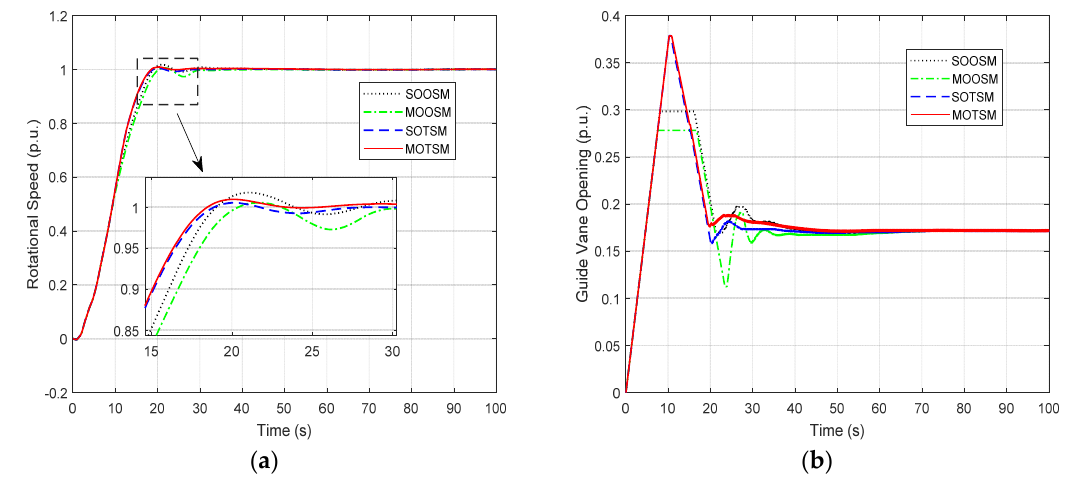
Figure 10. The transient processes of the rotational speed and guide vane opening with different solutions: ( a ) Rotational speed, ( b ) Guide vane opening of optimal solutions.